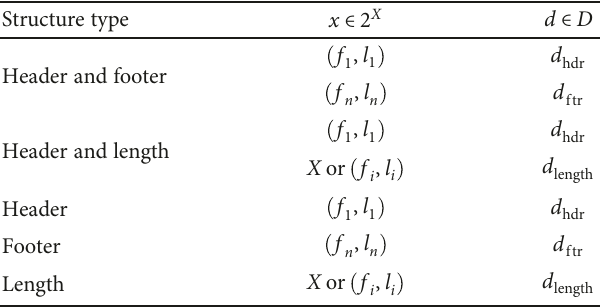
Table 3: Examples of X and D depending on type of message